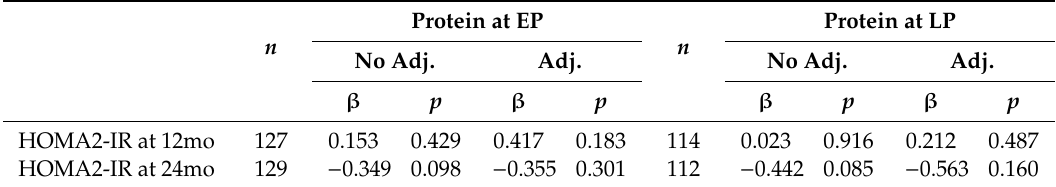
Table 3. Regression Analyses Comparing Maternal Dietary Protein Intake at Early (EP) and Late (LP) Pregnancy and O ff spring HOMA2-IR at 12 months (12mo) and 24 months (24mo). Protein at EP Protein at LP n n No Adj. Adj. No Adj. Adj. β p β p β p β p HOMA2-IR at 12mo 127 0.153 0.429 0.417 0.183 114 0.023 0.916 0.212 0.487 HOMA2-IR at 24mo 129 − 0.349 0.098 − 0.355 0.301 112 − 0.442 0.085 − 0.563